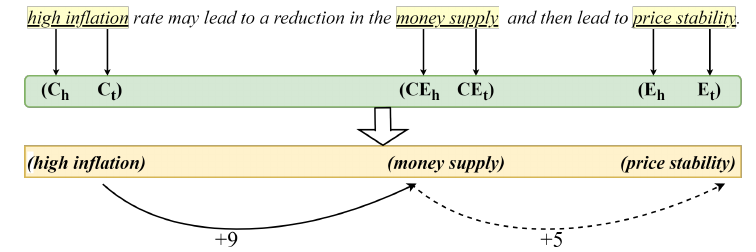
Figure 4. Chain causal sentence